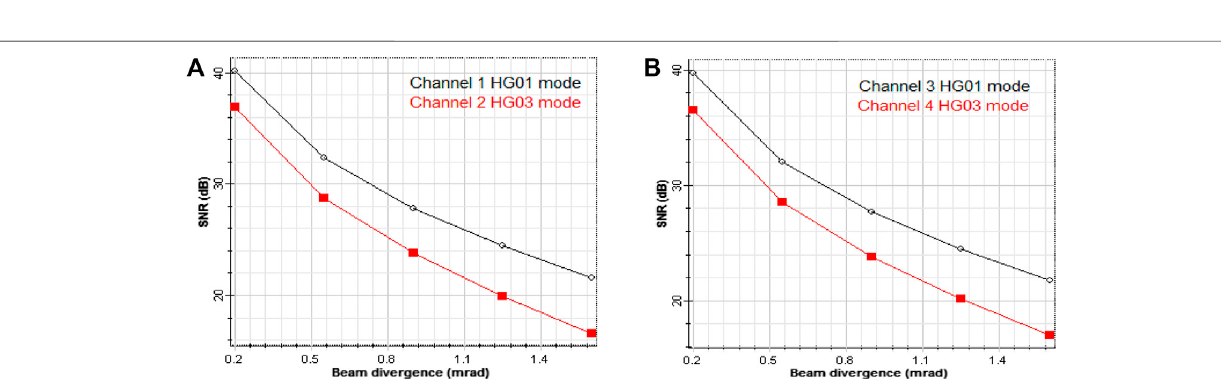
FIGURE 12 | SNR plots for (A) 1931. THz channel and (B) 193.2 THz channel under the effect of the beam divergence angle.